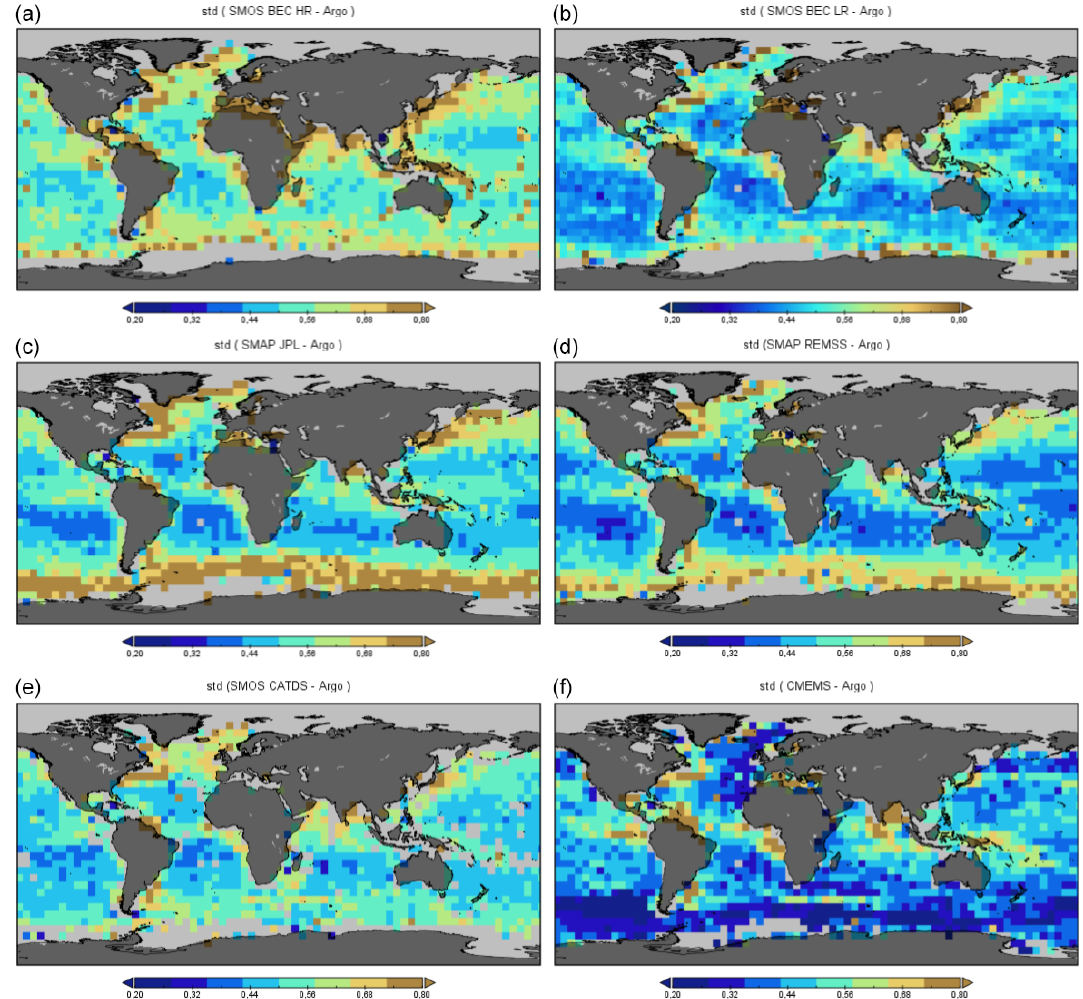
Figure 7. Spatial distribution of the standard deviations of the differences with respect to Argo SSS. From left to right and top to bottom: BEC HR, BEC LR, JPL, REMSS, CATDS, and